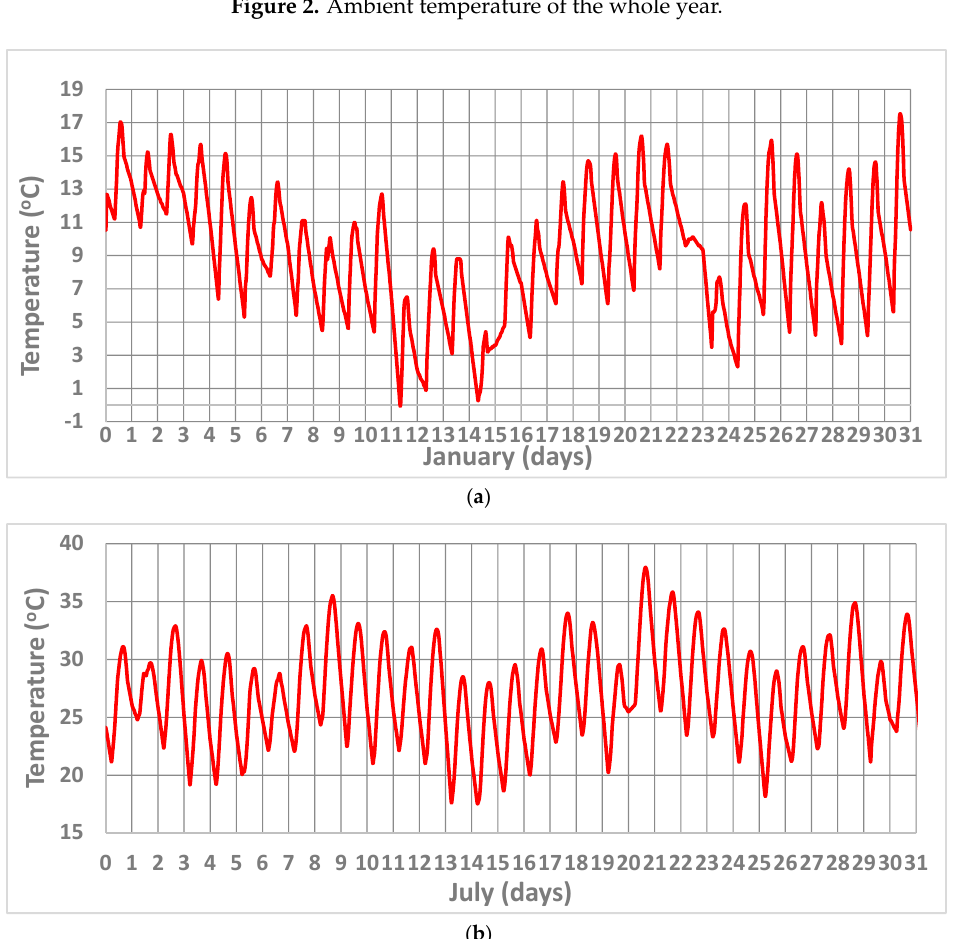
Figure 3. Ambient temperature of the ( a ) coldest month of the year—January; ( b ) warmest month of the year—July.